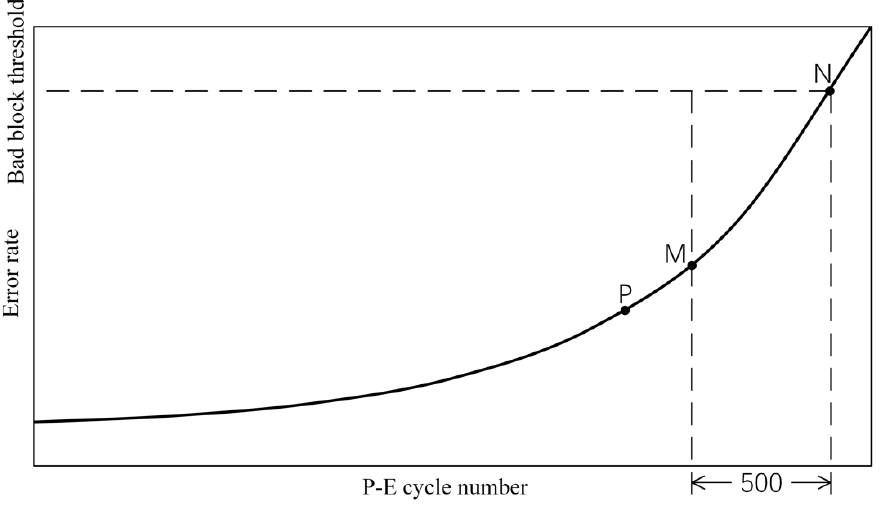
Figure 9. Schematic diagram of the flash block error rate and the number of P-E cycles.